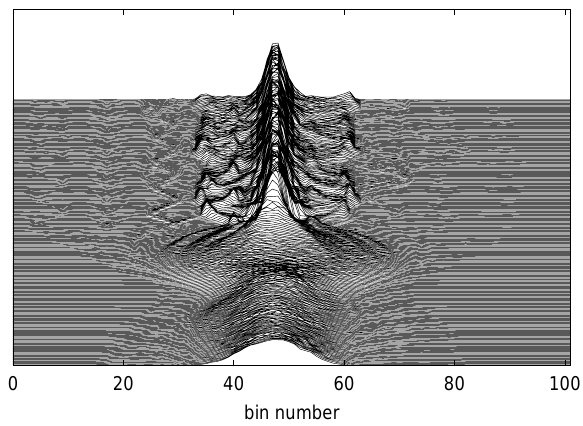
FIG. 4. Mountain range plot of 250 profiles, as obtained from the reconstructed phase space distribution. The time between profiles corresponds to 20 revolutions in the RHIC.